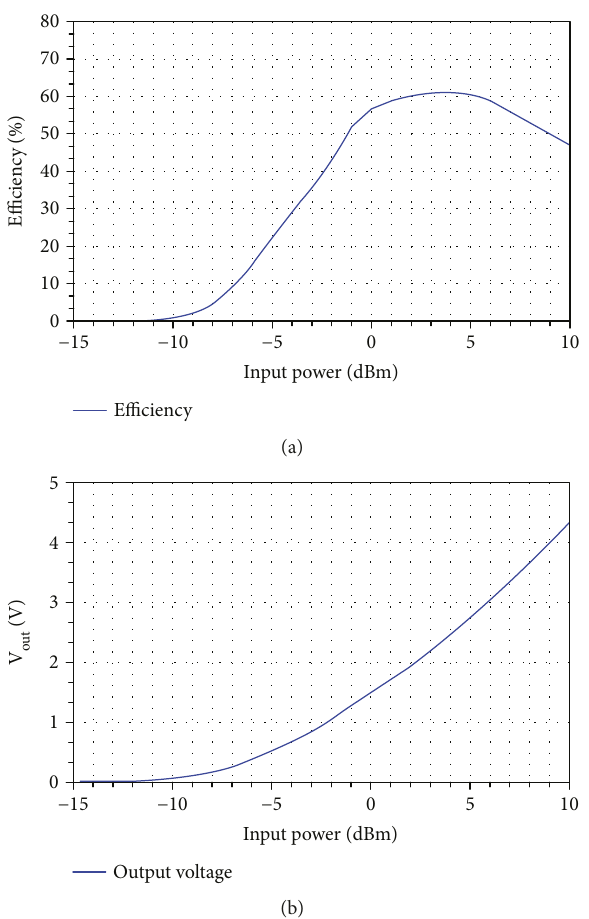
Figure 12: (a) RF-DC conversion e ffi ciency versus input power level at 5.82Ghz with the load of 3.9k Ω . (b) Voltage output versus input power level at 5.82Ghz with the load of 3.9k Ω .